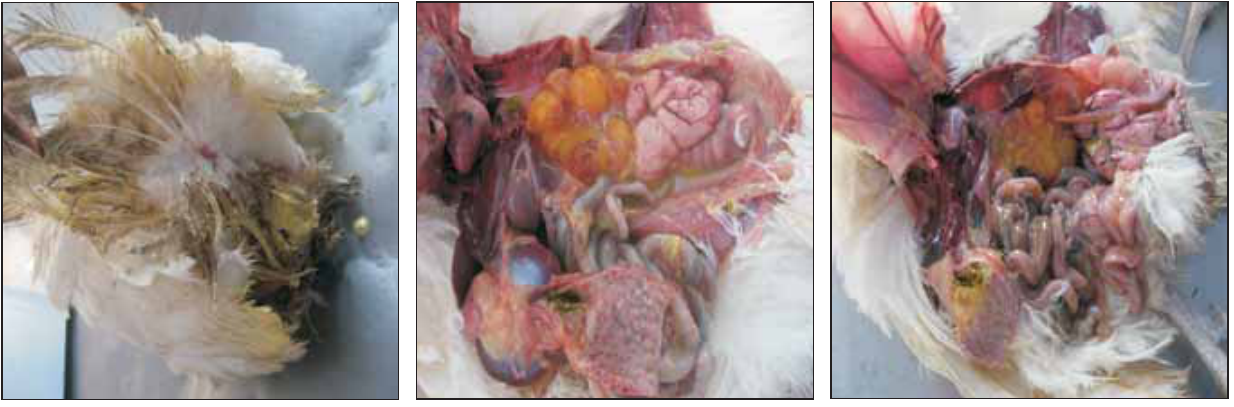
Figure-3: ND : Ovarian follicles were haemorrhagic, falccid and ruptured resulting in egg yolk